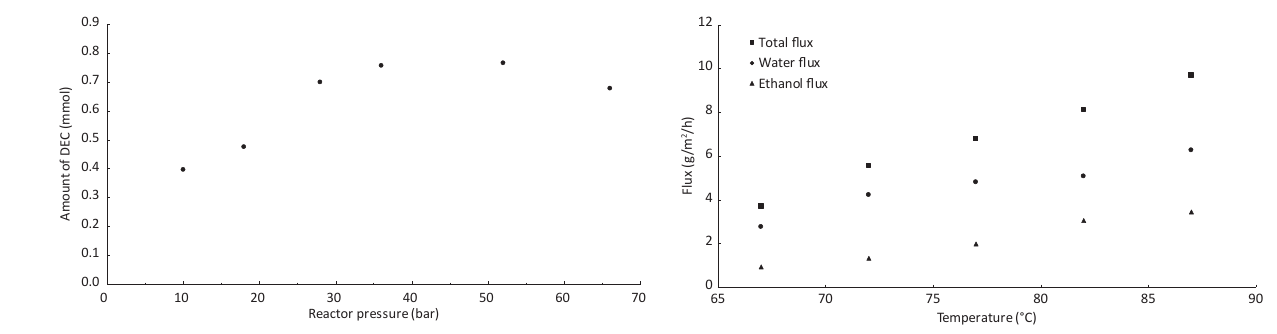
Figure 4: The dependence of the pressure on the amount of DEC produced.